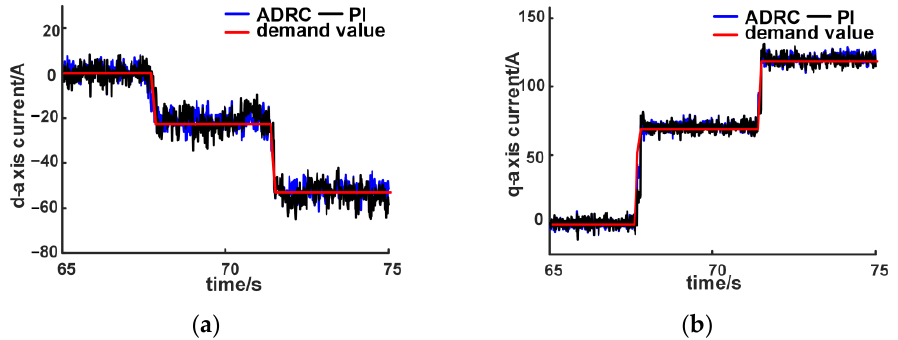
Figure 8. Small torque step response(200 r·min −1 ): ( a ) d-axis current; ( b ) q-axis current.